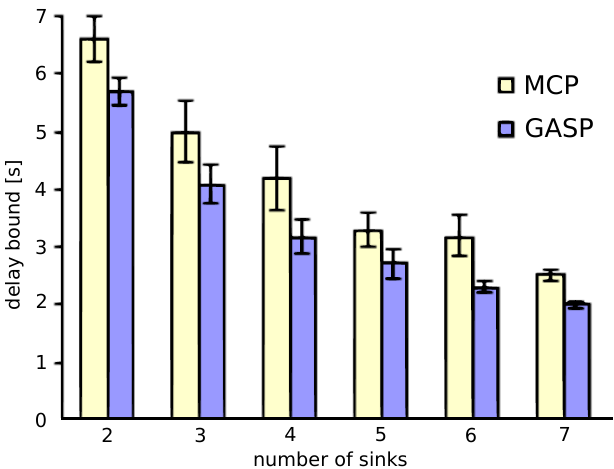
Figure 12. The worst case delay comparison of MCP vs. genetic algorithm-based heuristic for sink placement